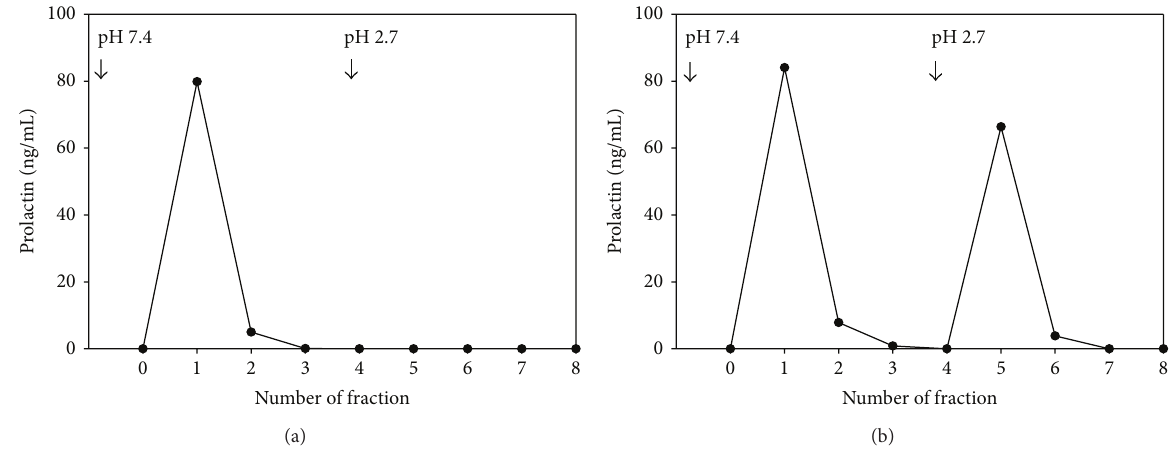
Figure 2: Representative affinity chromatography profiles of immunoreactive PRL in sera from one patient without anti-PRL autoantibody (a) and one patient whose test was positive for anti-PRL autoantibody (b) on a protein-G sepharose column (1mL). Samples (1mL) were applied on the column, and fractions of 1mL were